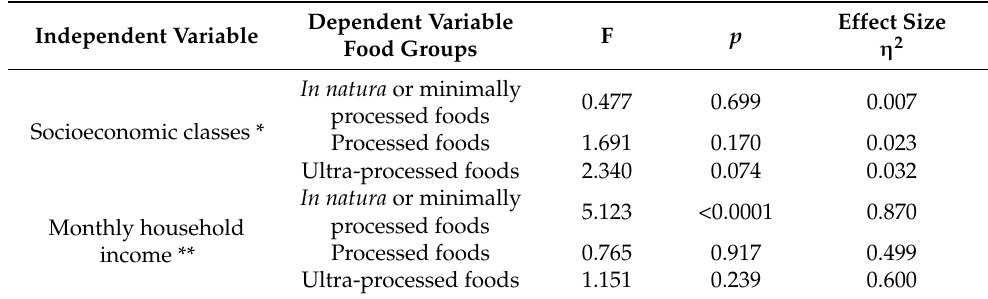
Table 3. Energy consumption according to socioeconomic classification and monthly household